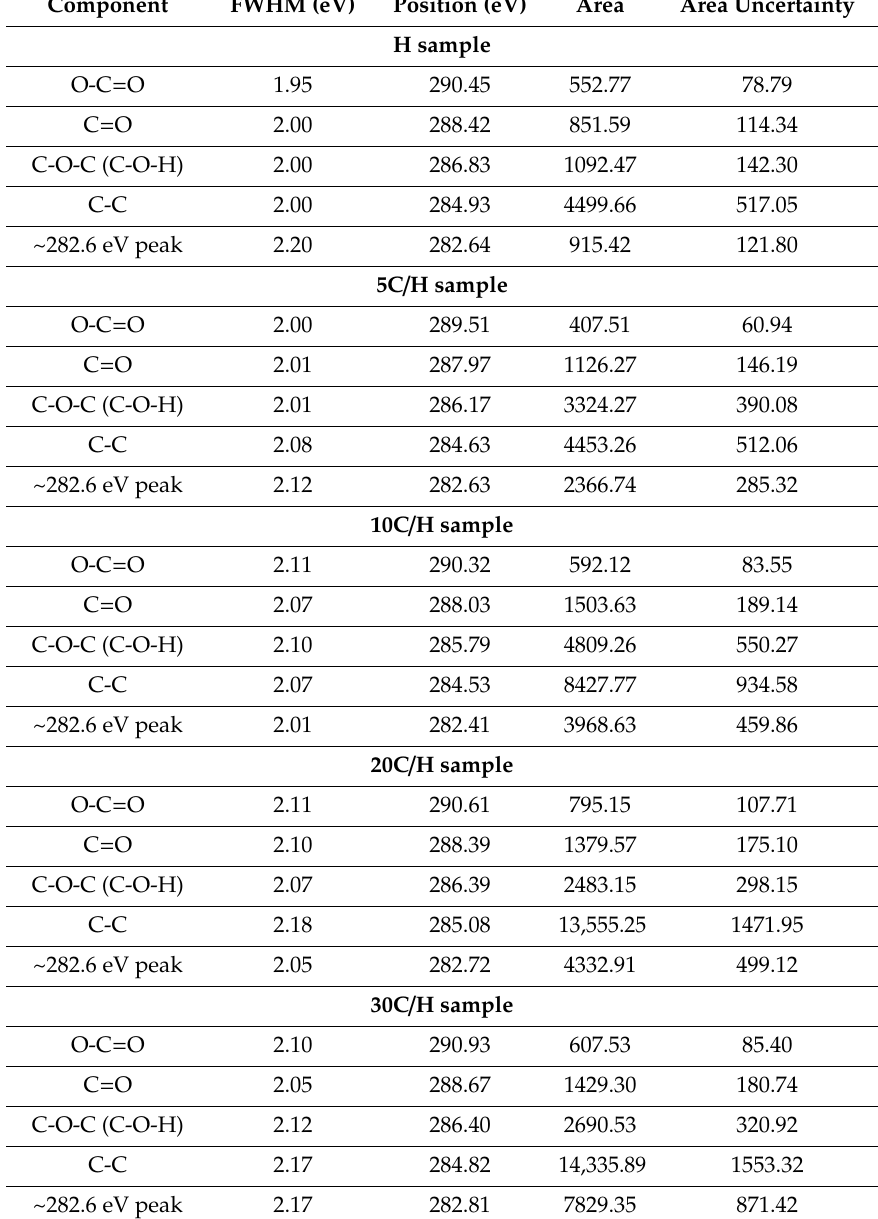
Table 2. Result of the C1s peak decomposition into components corresponding to di ff erent carbon bonds, obtained for the purified halloysite sample and 5 C / H, 10 C / H, 20 C / H, and 30 C / H halloysite-carbon